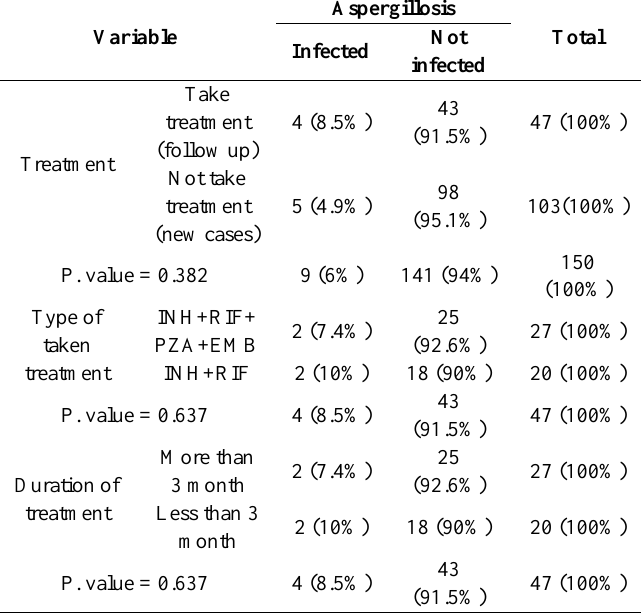
Table 4: Frequency of Aspergillus spp among the study population according to anti-tuberculosis treatment Variable